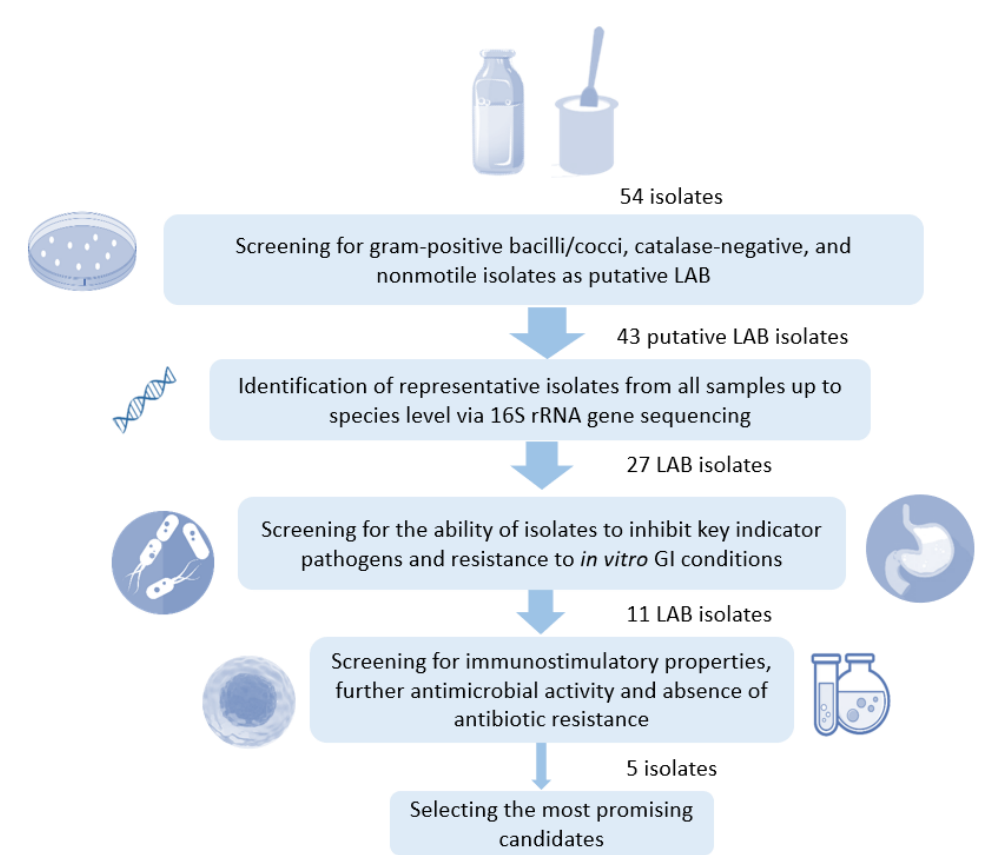
Figure 1. Strain selection flow chart used to select potential probiotic strains from Ethiopian yogurt and cheese products based on a combination of phenotypic and genotypic methods. Fifty-four isolates were obtained from Ethiopian yogurt and cheese-based products. Of these, 43 were classified as putative LAB. After initial antimicrobial analysis, 27 isolates were selected (taking into account origin) for 16S rRNA analysis. Of these 27 isolates, 11 were selected based on initial antimicrobial screening and species diversity for in-depth characterization of their probiotic potential. Of these, 5 isolates scored the best on all tests and were selected as the most promising probiotic candidates.